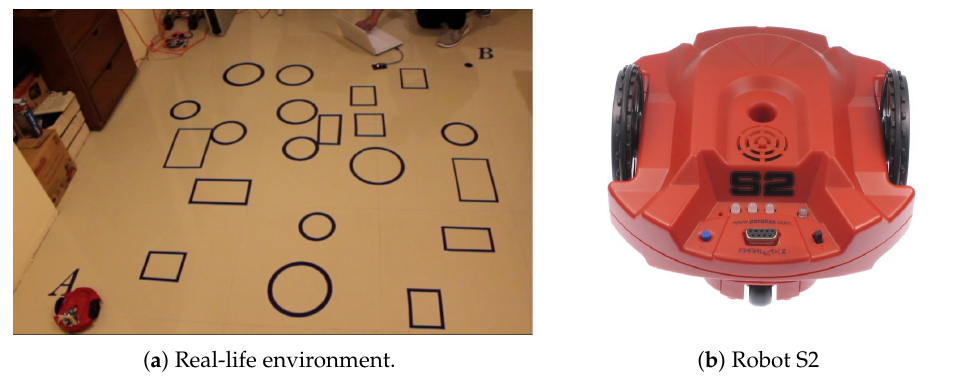
Figure 13. Controlled device.